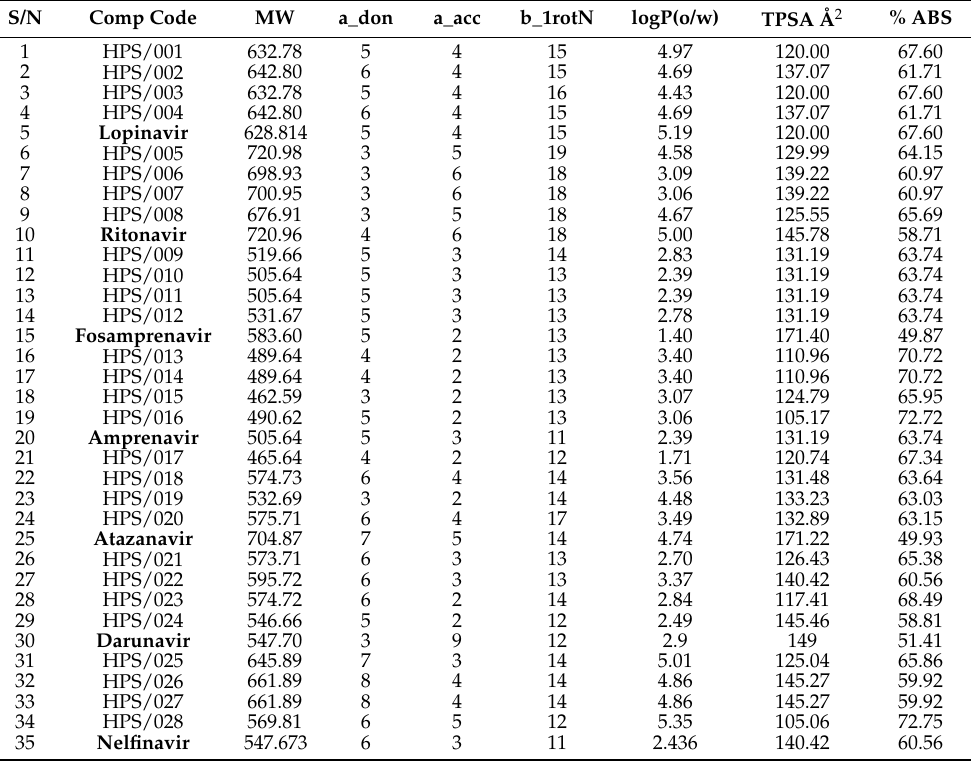
Table 1. The physicochemical properties of the selected